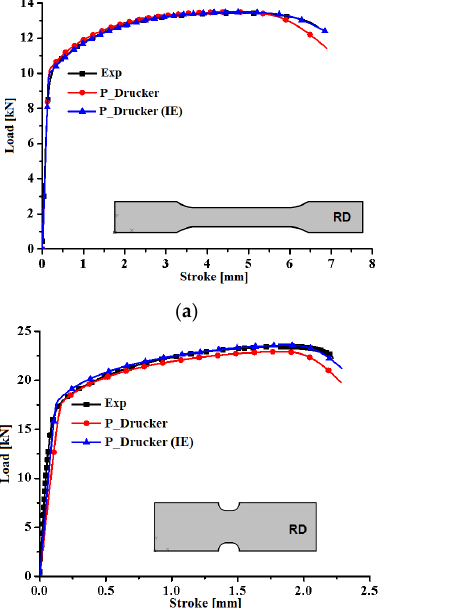
Figure 10. Comparisons of the load-stroke curves between the experiments and simulations after the inverse engineering optimization: ( a ) dog-bone specimen; ( b ) specimen with a central hole; ( c ) notched specimen; ( d ) in-plane shear specimen.